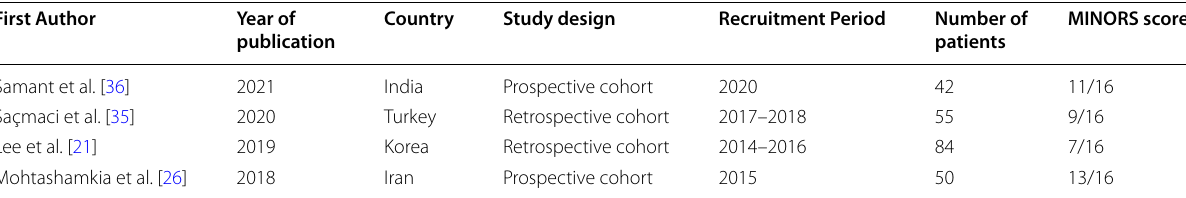
Table 1 Characteristics of included studies